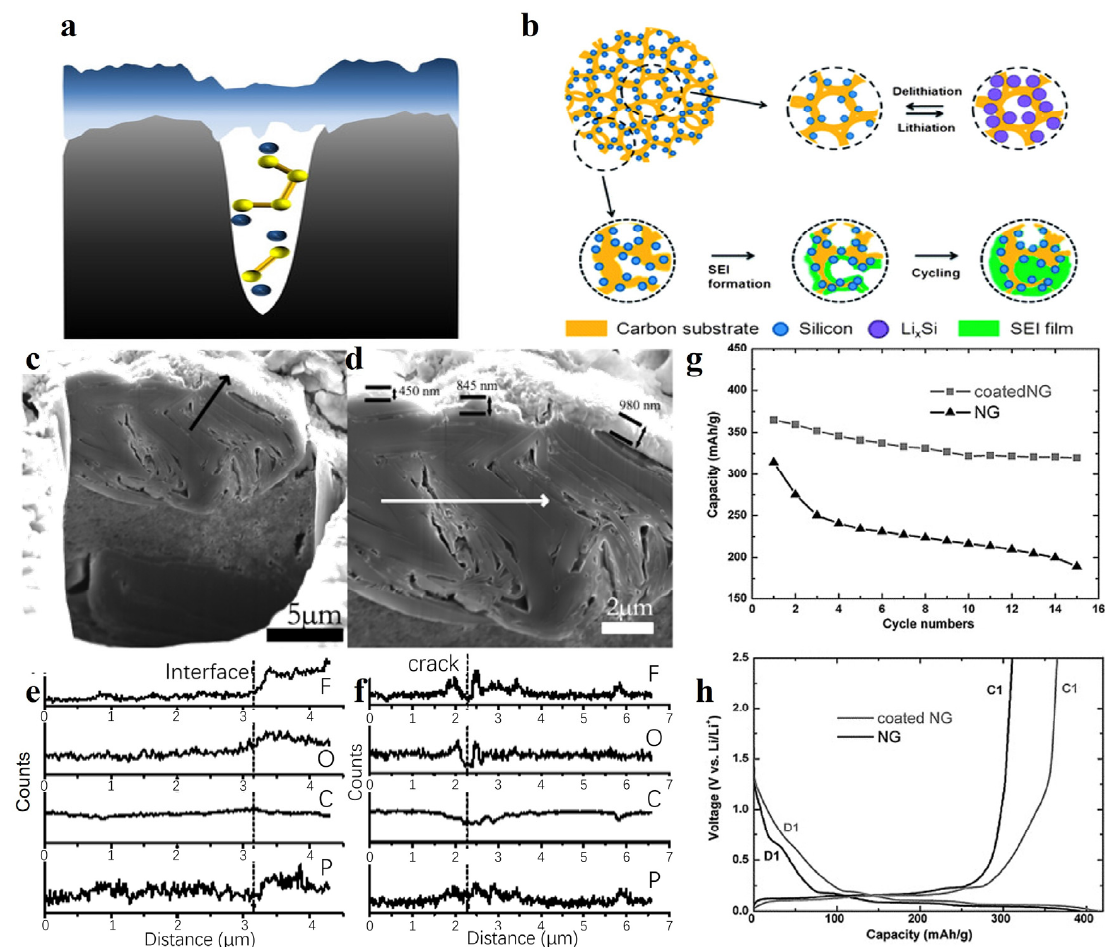
Figure 7. Schematic illustration of ( a ) a closed protective cathode electrolyte interphase [98], copyright 2020, Wiley-VCH and ( b ) formation and confinement of SEI film in porous silicon/carbon composites [101], copyright 2013, Royal Society of Chemistry. ( c , d ) SEM images of the cross section of a natural graphite sphere; ( e , f ) the elemental line scan analysis along the black and white lines in panels c and d, respectively [102], copyright 2005, American Chemical Society. ( g ) Comparison of cyclic performance for the original and coated NG spheres at a 0.2 mA cm − 2 and ( h ) voltage profiles of the original and coated NG spheres, where D1 and C1 represent the first discharge and charge processes, respectively [103], copyright 2006, Elsevier.